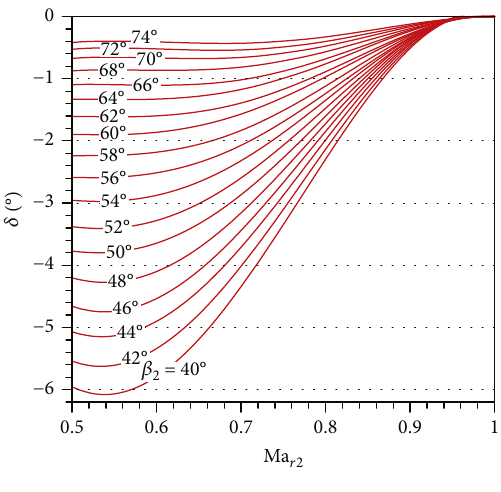
Figure 3: Deviation angle